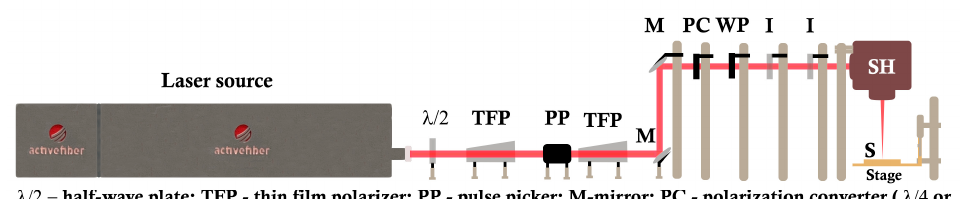
Figure 1. Schematic of the experimental setup.